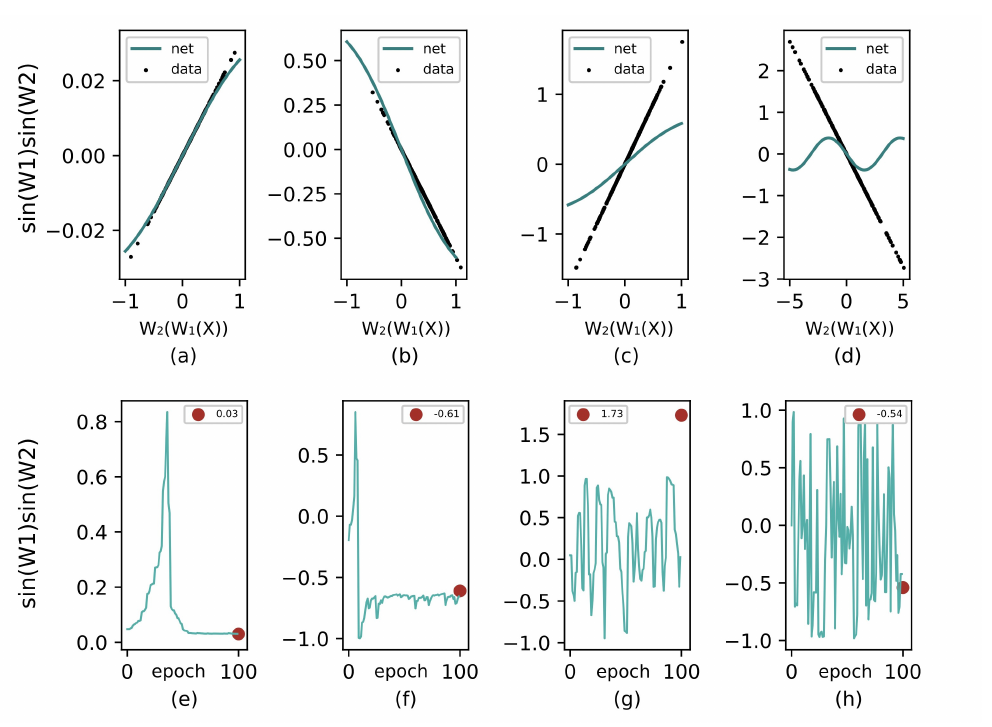
Figure 4. Line fitting and learning dynamics of trigonometric inference under various conditions. The initial parameters for ( a – d ) are listed in Table 2. ( a , e ) represent an ideal condition in which samples are concentrated around 0. ( b , f ) represents a situation in which samples are drawn from comparatively large means. ( c , g ) depict the learning dynamics when the slope is larger than 1, which is impossible for sine activation to reach. ( d , h ) designate a large sample